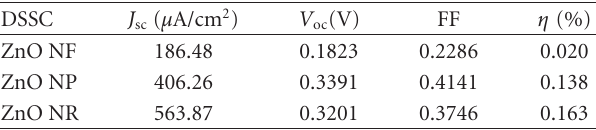
Figure 8: Typical photocurrent-voltage (J-V) characteristics of the ZnO morphologies/Eosin Yellowish dye-sensitized solar cell using the PEO/TiO 2 /LiI/I 2 composite polymer electrolyte. Table 2: Photovoltaic parameters of DSSC made with di ff erent